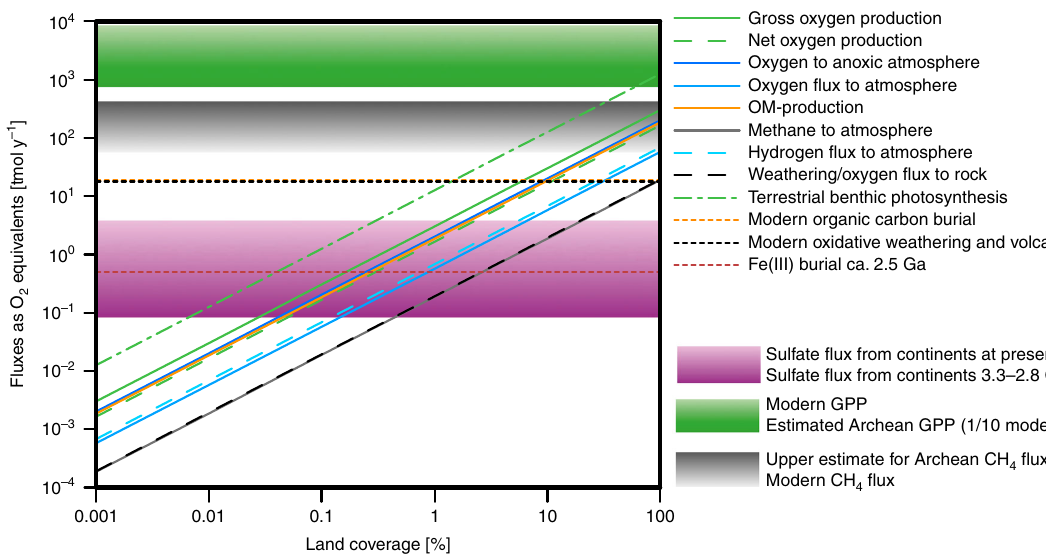
Fig. 6 Global elemental budgets and fl uxes. Land coverage is based on a total land surface area of 2.5 × 10 7 km 2 (ref. 50 ). At about 0.02% land coverage, the measured gross oxygen production could account for the present sulphate fl ux and would exceed historic values. At a coverage of about 1%, it would match modern oxidative weathering and volcanism, or modern organic carbon burial. A coverage of more than 100% is required to reach the estimated Archean gross marine primary productivity. Shaded areas for sulphate fl ux, methane fl ux, and gross primary productivity refer to fl uxes ranging from Archean (darker colours) to present (lighter colours) values. Horizontal lines represent global production, diagonal lines represent terrestrial production dependent on land coverage (modi fi ed after 44 ). Values according to ref. 44 were recalculated for 2% of land surface to be covered by rivers and lakes